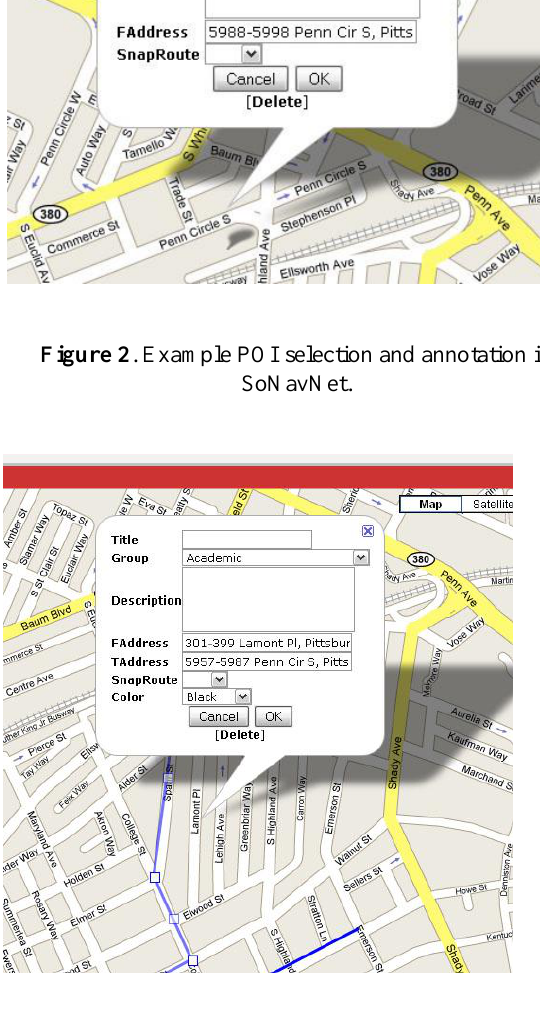
Figure 3. Example ROI selection and annotation in SoNavNet.